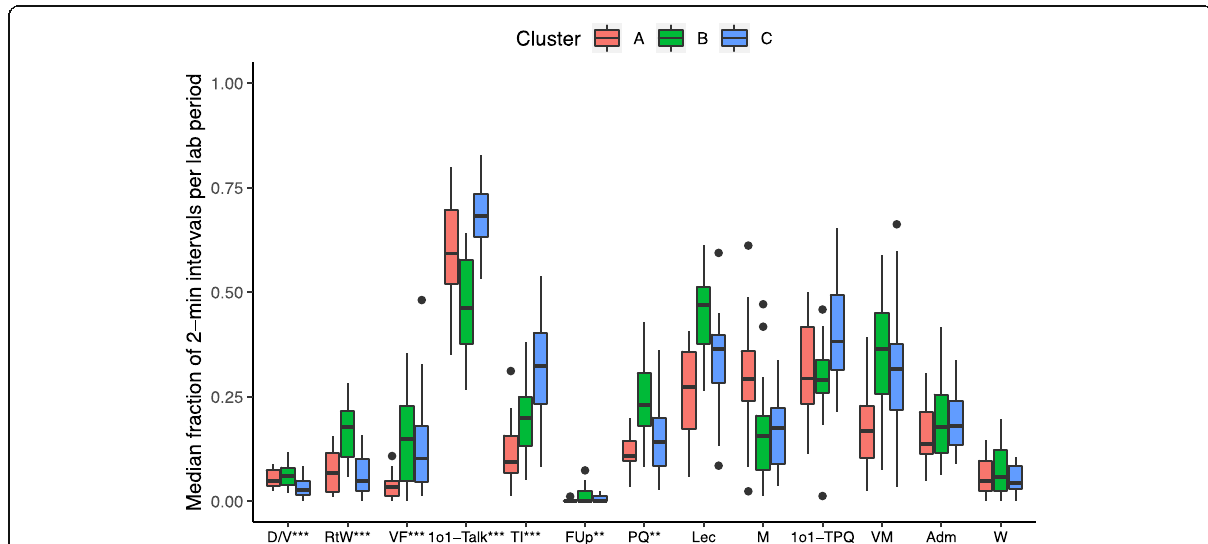
Fig. 2 Median fraction of GTA codes in each cluster. Seven codes are statistically significantly among clusters, five of which (D/V, RtW, VF, 1o1-